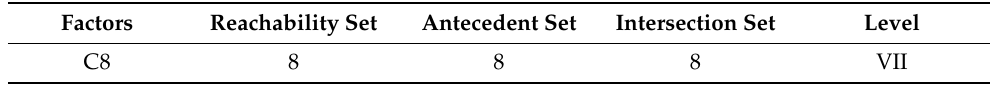
Table A4. Iteration